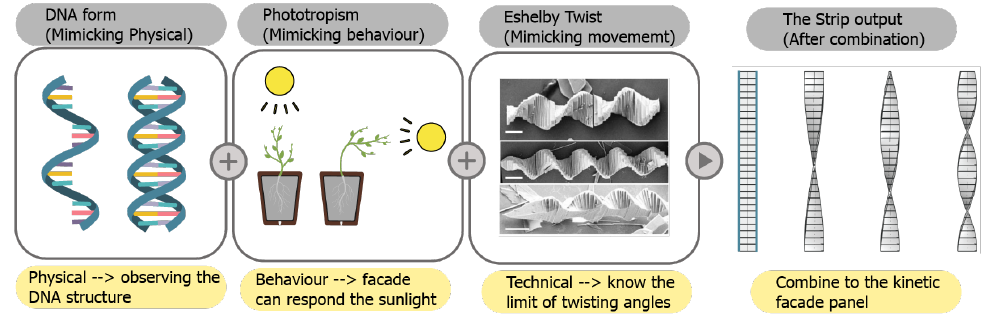
Figure 7. Inspiration for a façade merging physical DNA and phototropism